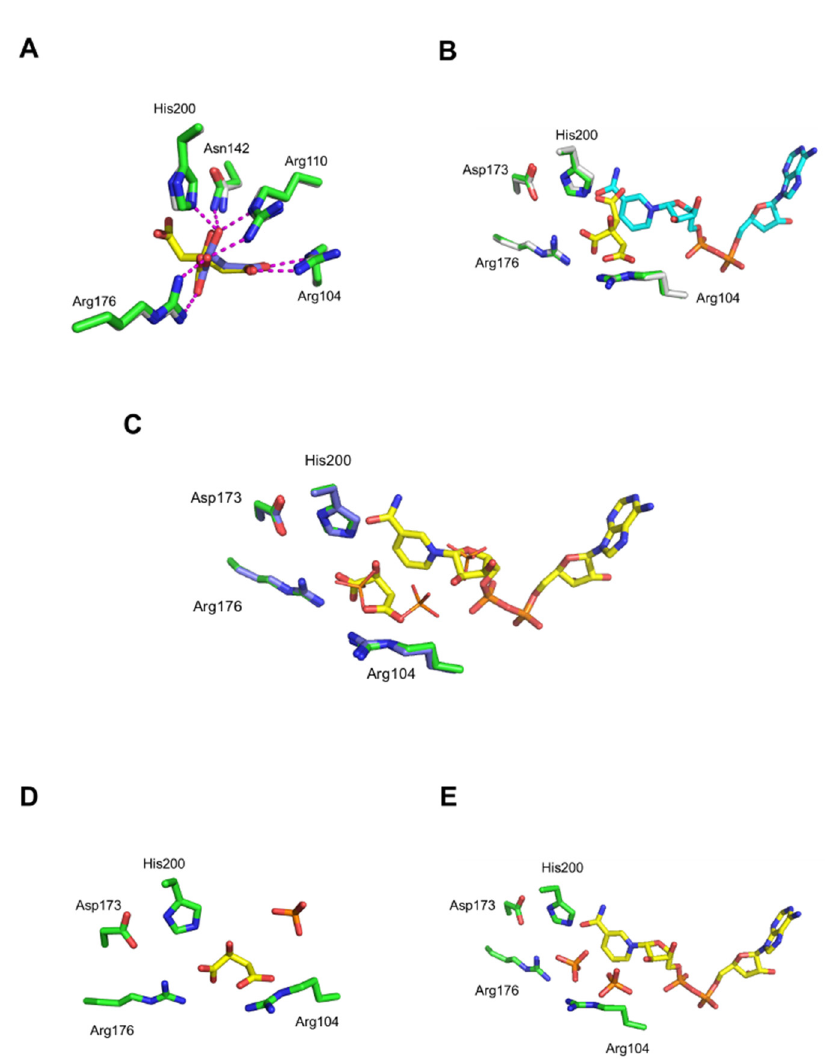
Figure 2. Comparison of active site of hMDH2. The active site is shown, and the residues and ligands are displayed as sticks or lines. ( A ) Superimposed active sites of citrate bound (residues in green and citrate in yellow) and L -malate bound (residues in gray and L -malate in purple) structures. ( B ) Superimposition of citrate bound (colors the same as in A) and NAD bound (residues in white and NAD in cyan) structures. ( C ) Superimposition of phosphate bound (residues in purple and phosphate in orange) and L -malate-NAD bound (residues in green and ligands in yellow) structures. Phosphates are displayed as lines. ( D ) Active site of the malate bound structure; ( E ) active site of the NAD bound structure. In both ( D , E ), phosphates are colored in orange.